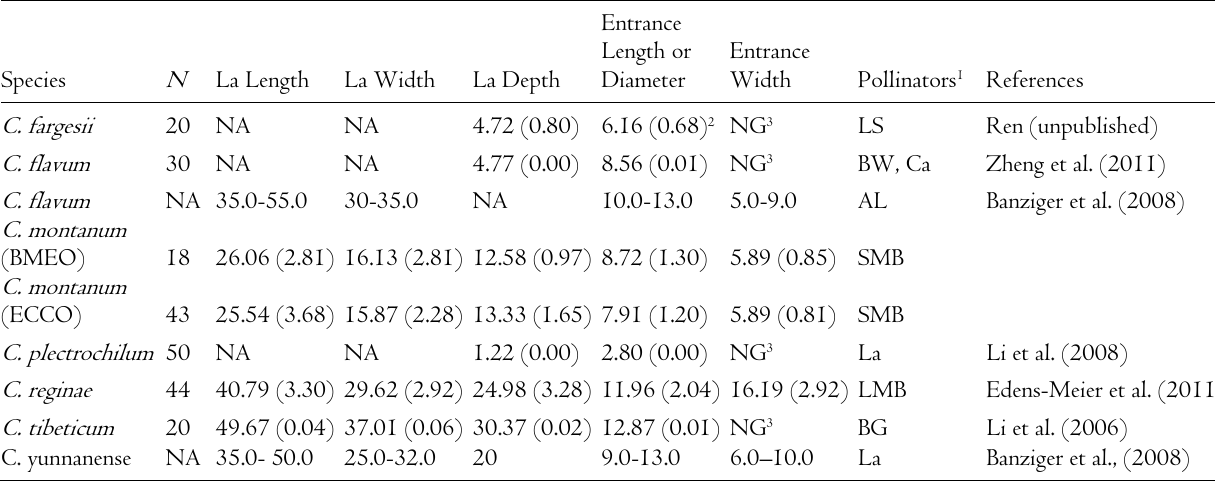
Comparative of the labellum in Cypripedium spp. (mean and standard deviation, in mms).